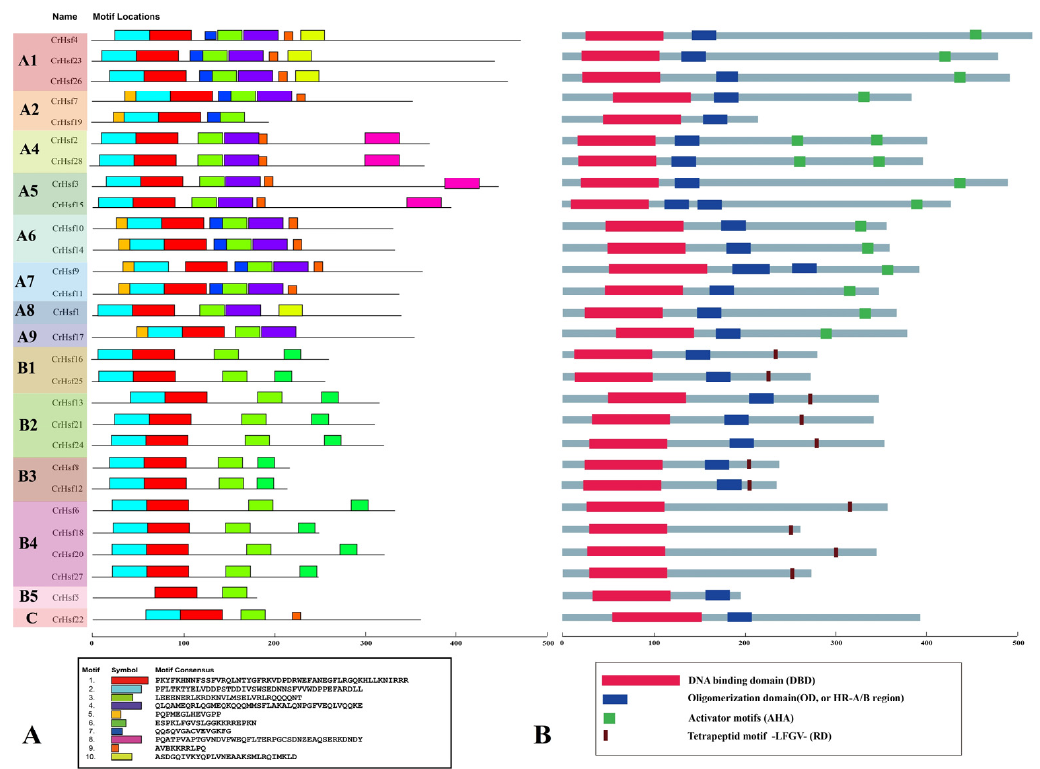
Figure 2. The motif composition predicted by the MEME prediction (http://meme-suite.org/, accessed on 1 May 2022) ( A ) and the conserved domain diagram drawn manually ( B ) of C. rosea Hsf proteins. The far left indicates the constructed phylogenetic tree with MEGA 6.0, including group A (A1, A2, A4, A5, A6, A7, A8, A9), group B (B1, B2, B3, B4, B5), and group C. The ten conserved motifs are listed in the left bottom box, and the four functional domains, including DBD, OD, AHA, and RD, are listed in the right bottom box.